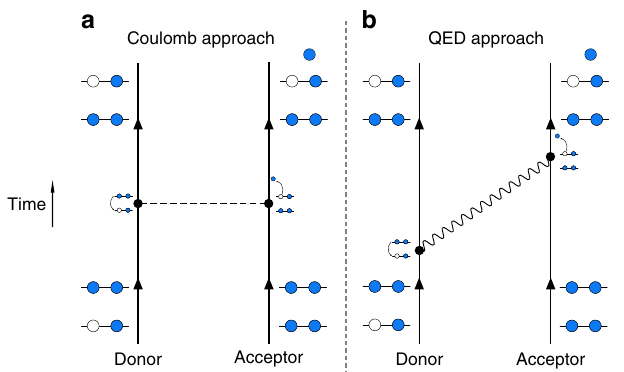
Fig. 1 Interatomic Coulombic decay process. Illustration of the interatomic Coulombic decay process in terms of a the traditional language of Coulomb interactions and b our quantum electrodynamics approach. An ionised, excited atom or molecule (donor) with an inner-valence vacancy (sometimes known as hollow) makes a transition where that vacancy is fi lled and a photon is emitted. If that photon has an energy higher than the photoionisation threshold of a neighbouring atom or molecule (acceptor), its absorption may be accompanied by an electron being freed into the continuum. The resulting pair of ions then undergoes a ‘ Coulomb explosion ’ , which is one of the experimental signatures of